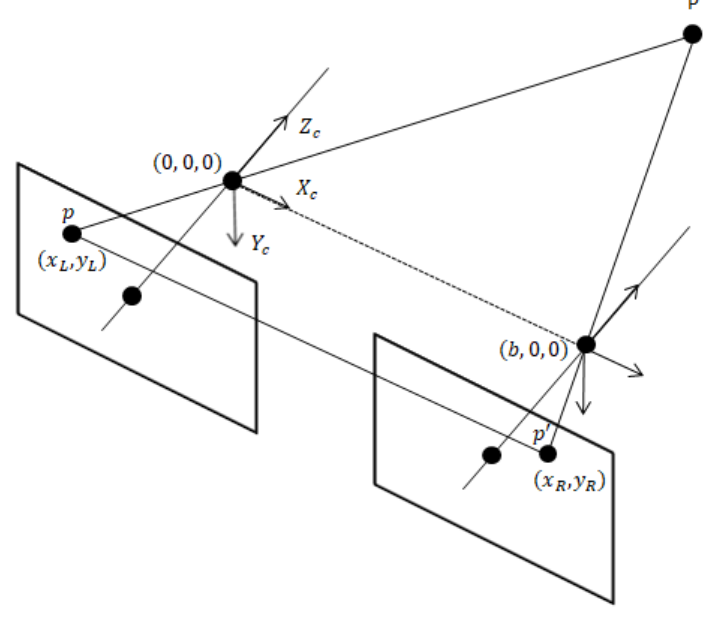
Figure 4. Configuration of stereo